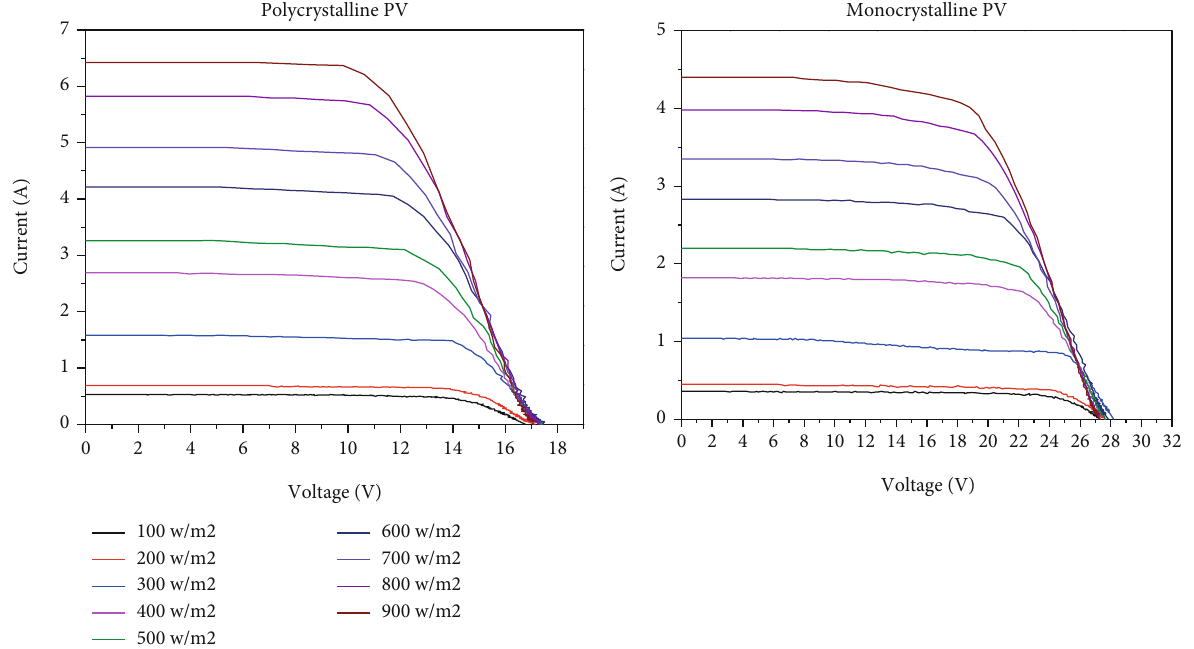
Figure 6: I - V curve of the panels.